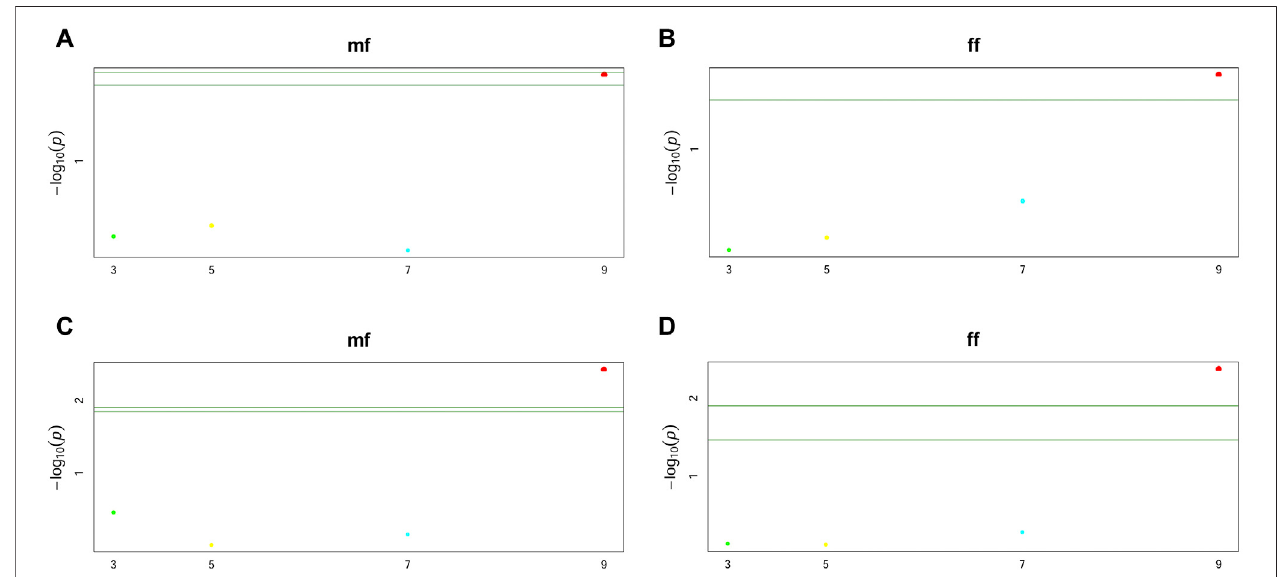
FIGURE 6 | Manhattan plots of GWAS for male (mf) and female (ff) fl owering time using the knob positions K3L, K5L, K7S, and K9S. (A,B) are plots showing the allele substitution effect model (C,D) the dominance effect model, both with p -values < 0.05. The green lines are the signi fi cance threshold, a Bonferroni-corrected signi fi cance threshold used to identify signi fi cant associations.